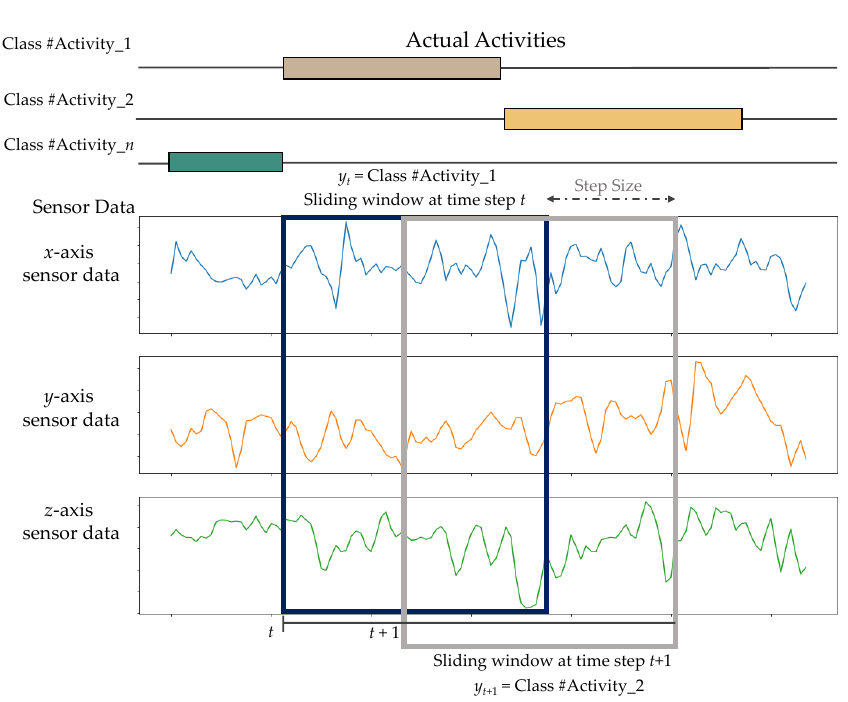
Figure 4. Fixed-length sliding window technique used in this work.